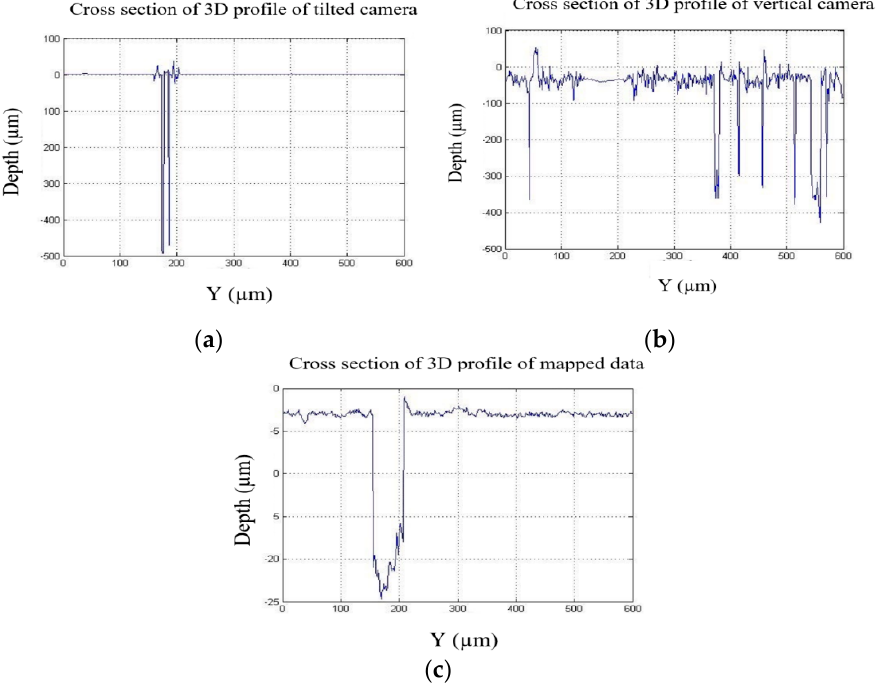
Figure 12. Height cross-section of a surface cross-section on the wafer in Figure 1: ( a ) reconstructed cross-section profile by capturing specular light. ( b ) reconstructed cross-section profile by capturing diffuse light, and ( c ) mapped cross-section profile.